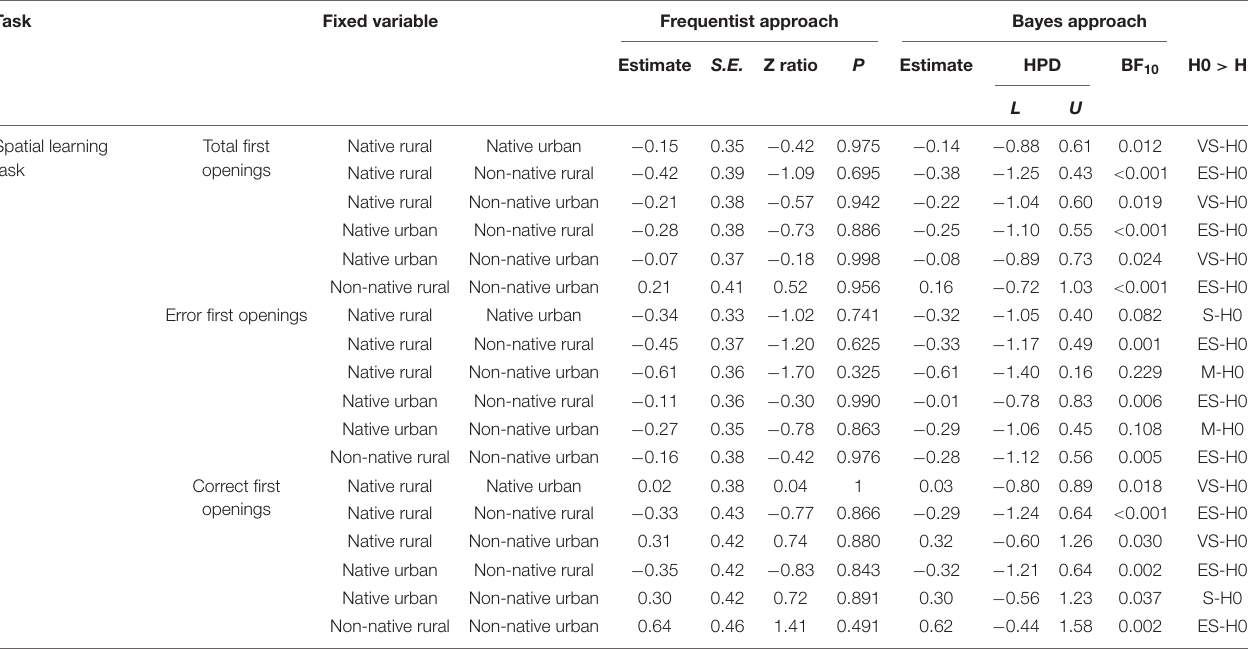
TABLE 5 | The spatial learning task: results of GLMM and Bayesian approach testing the effect of squirrel group (native rural, native urban, non-native rural, and non-native urban group), success block number, and their interaction on the performance of the spatial learning task.